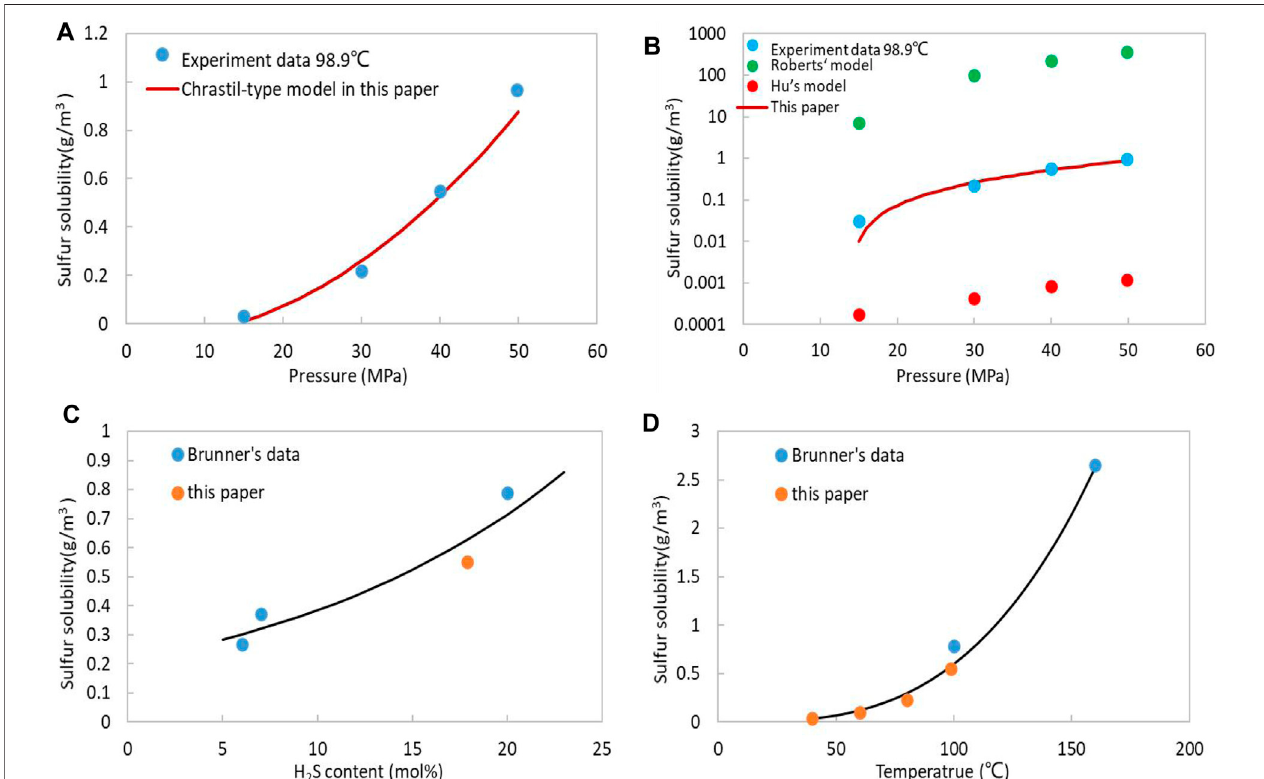
FIGURE 3 | Comparison of sulfur solubility with published data. (A) Effect of pressure at 98.9 ° C; (B) Experimental sulfur solubility of this paper and published data. (C) Effect of H 2 S content at 40 MPa, 100 ° C; (D) Effect of temperature at 40